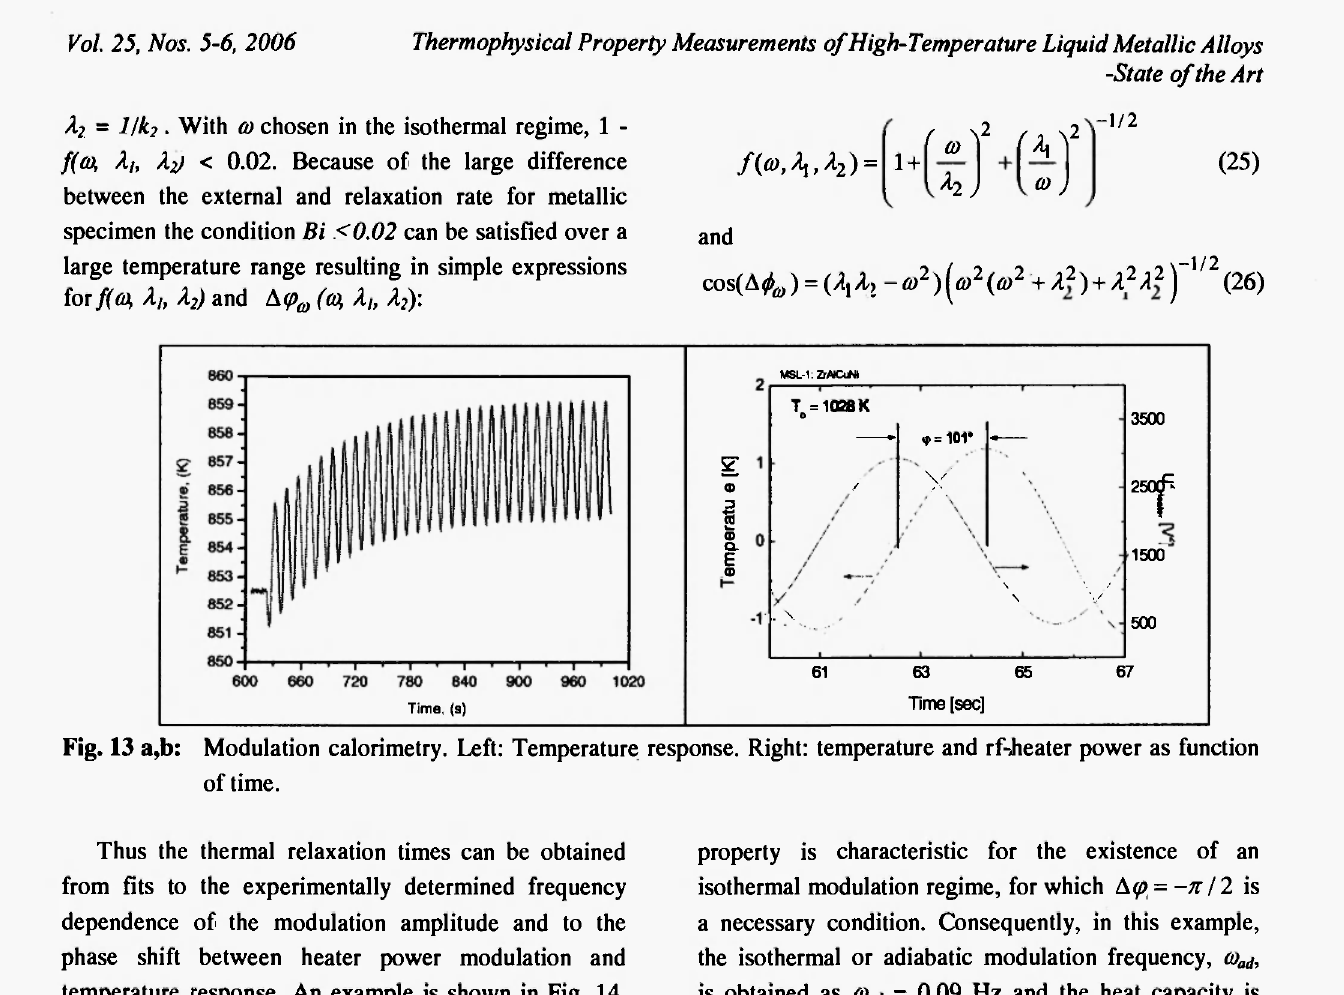
Fig. 13 a,b: Modulation calorimetry. Left: Temperature response. Right: temperature and rf-vheater power as function of time.